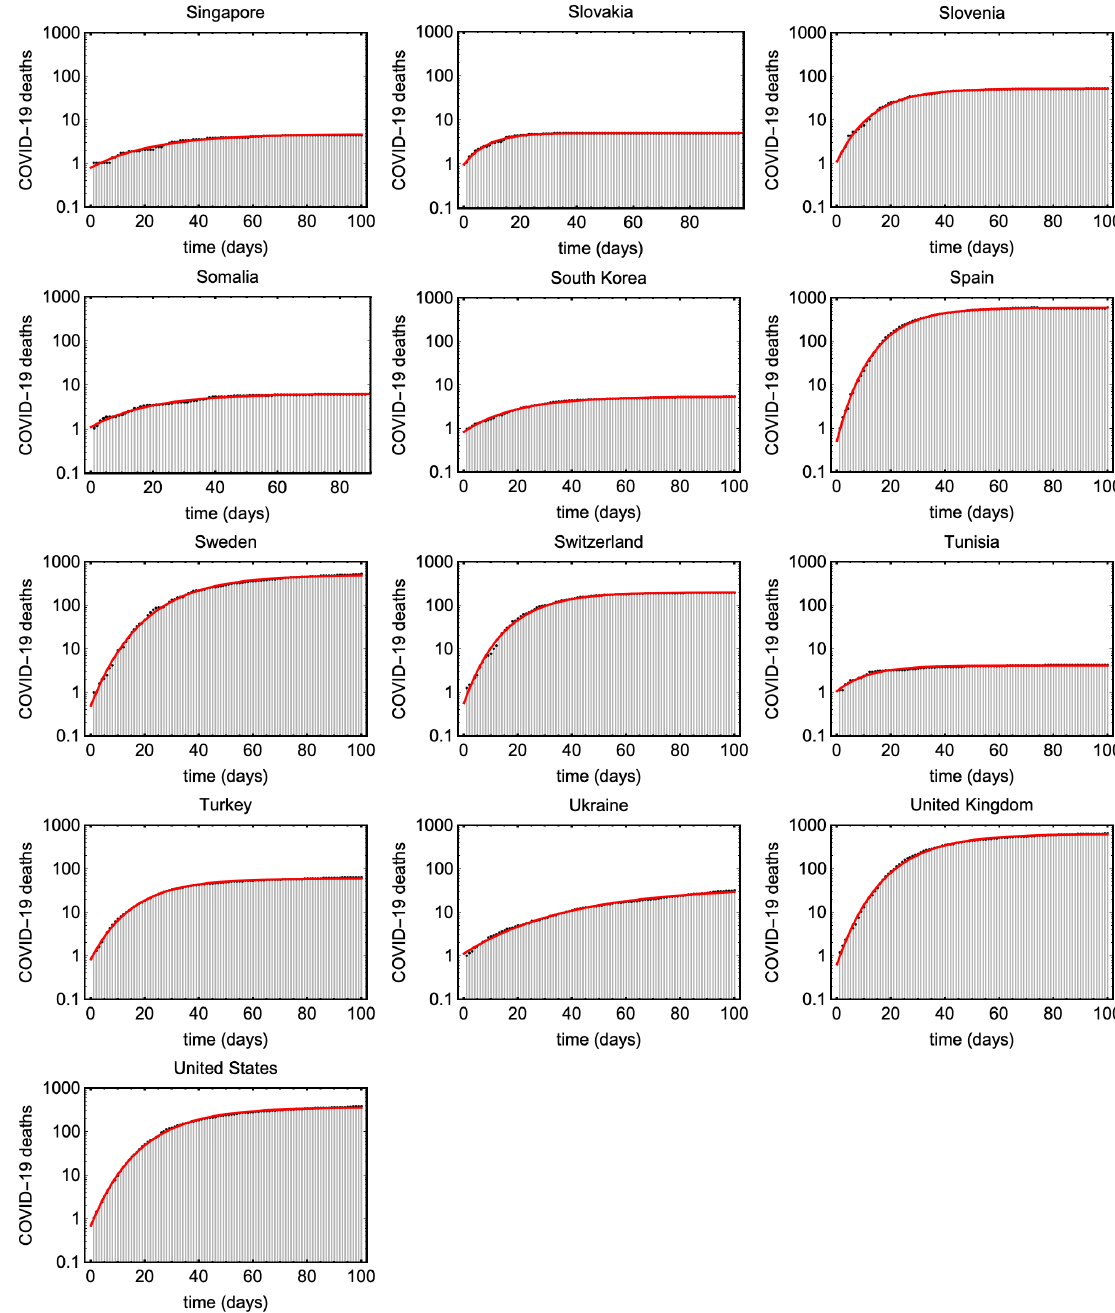
Figure A7. Shows cumulative COVID19 deaths (black) and the estimated Gompertz curves for different countries